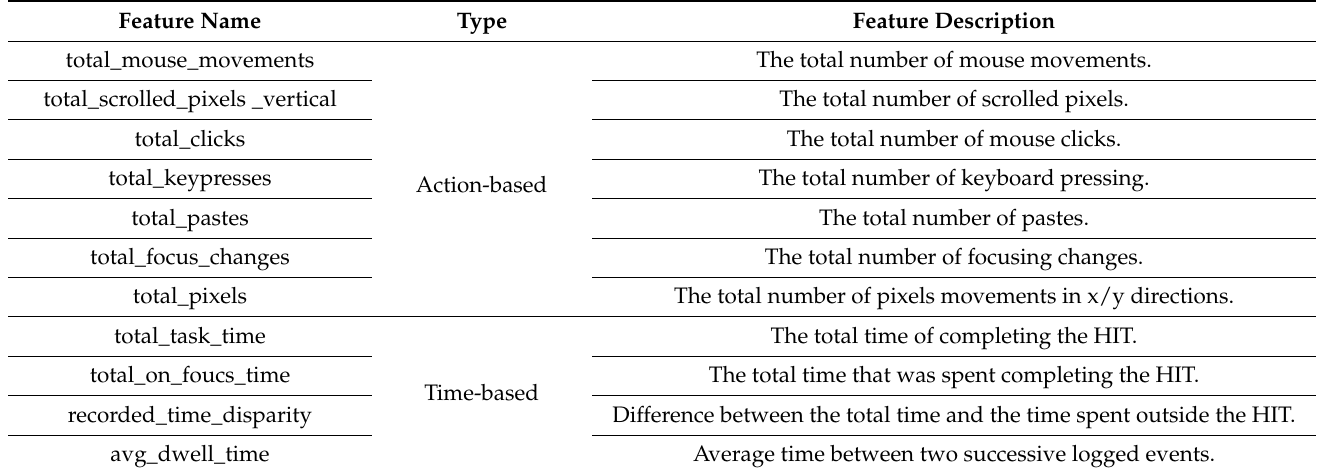
Table 1. The auxiliary features for image-CNN